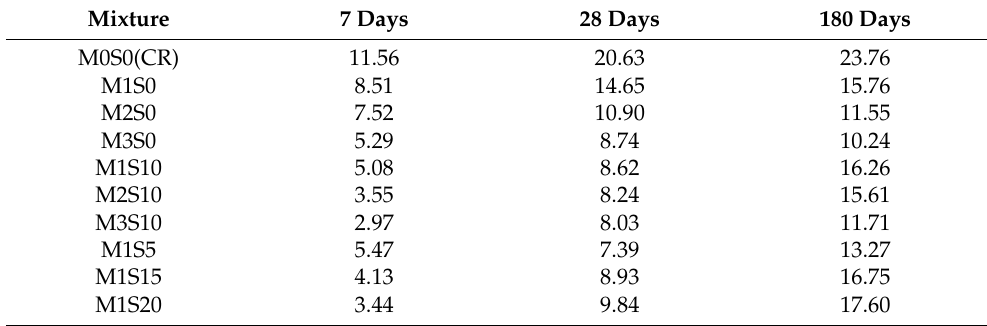
Table 5. Compressive strength